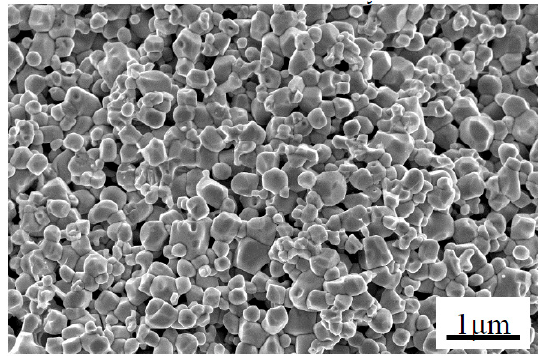
Figure 3. Secondary electron SEM images of fracture surface of monolithic ZrB 2(nano) .